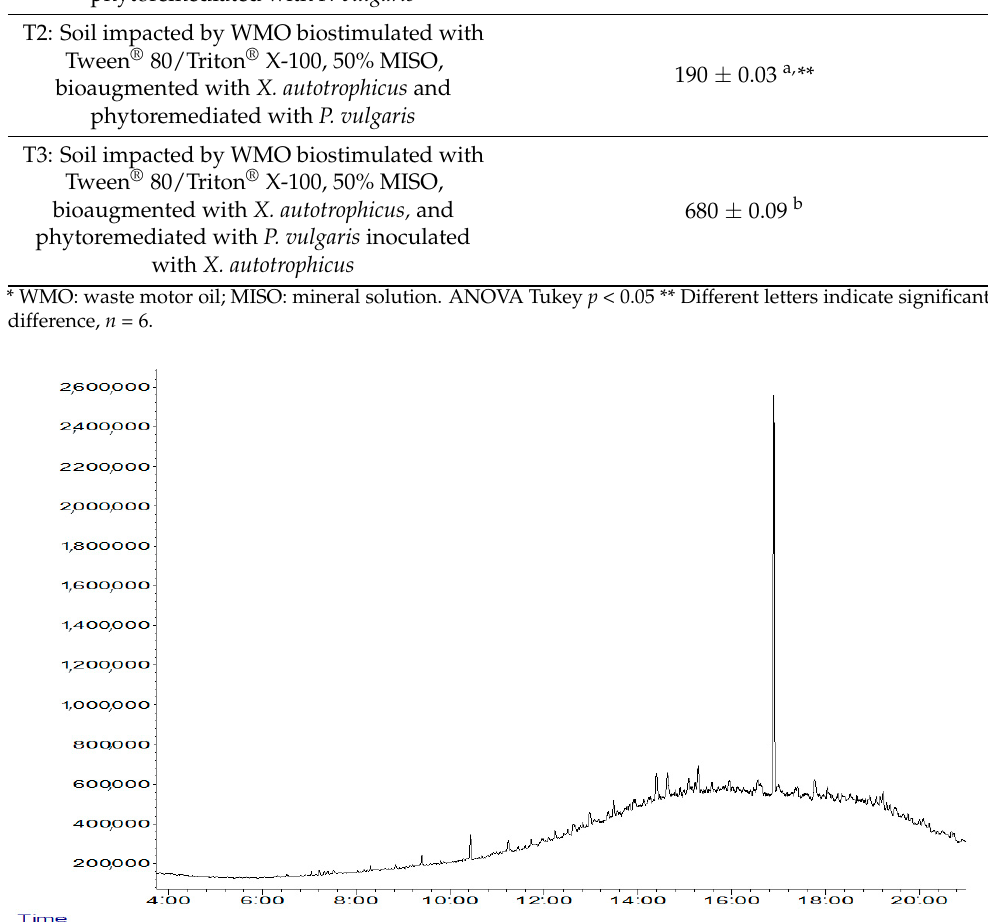
Figure 2. Chromatogram of 14 C, 36 C aromatic and 17 C aliphatic hydrocarbons in WMO after biostimulation, bioaugmentation, and phytoremediation .